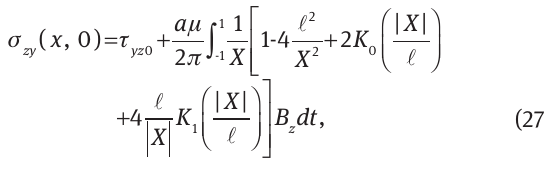
for ℓ = 0.1 a , in compari- yz